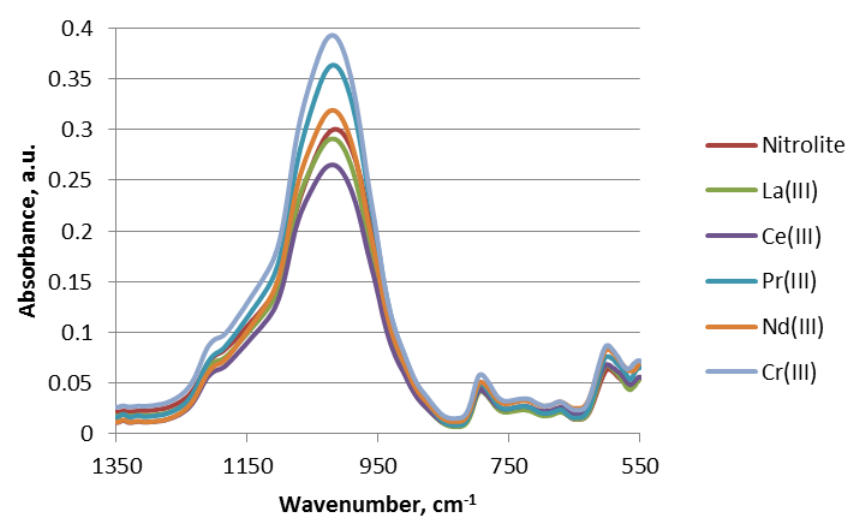
Figure 5. The ATR - FTIR spectra for Cr(III), La(III), Ce(III), Pr(III) and Nd(III) ions on Nitrolite.